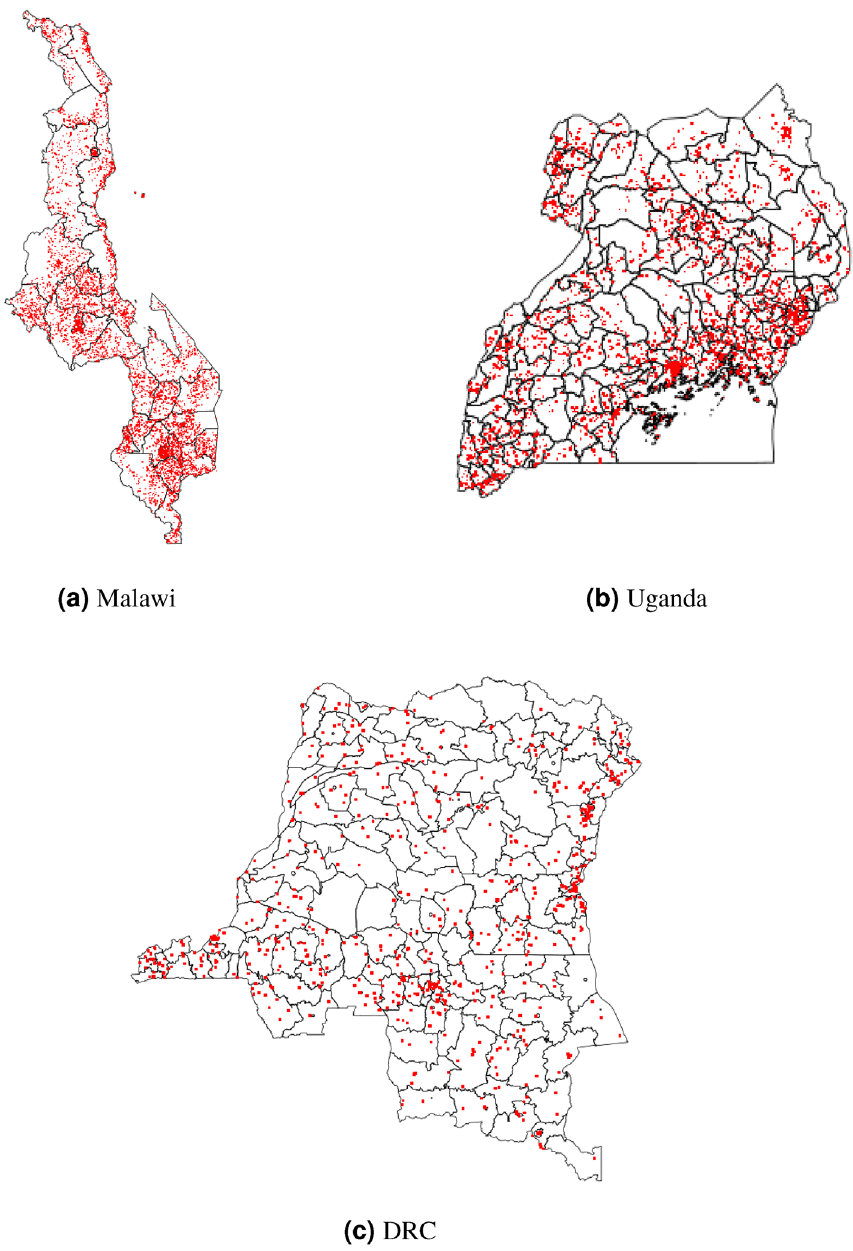
Figure 1. Spatial distribution of survey clusters (observed data) across all years. Size of the red dots does not scale with data